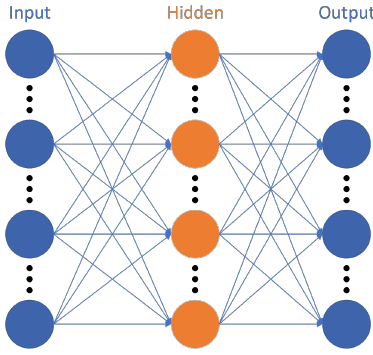
Figure 2. Diagram of a